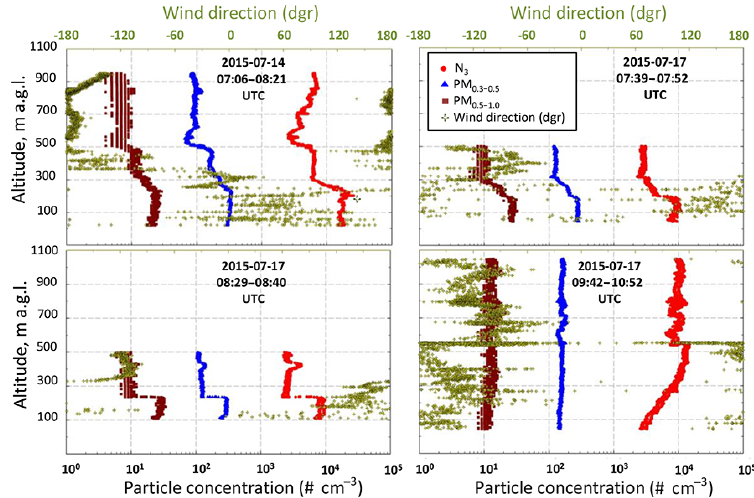
Figure 10. Vertical profiles of particle number concentrations for particles > 3nm (red, N 3 ) , 0.3–0.5µm (blue, PM 0 . 3 − 0 . 5 ) , 0.5–1.0µm (maroon, PM 0 . 5 − 1 ) and wind direction obtained with the tethered balloon measurements on 14 and 17 July 2015.